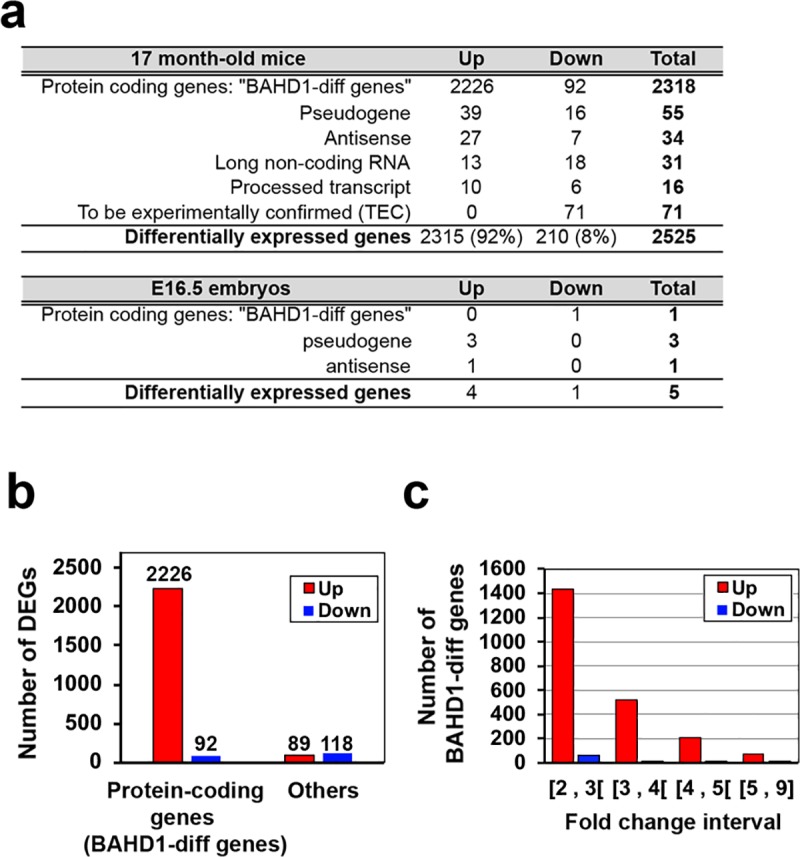
BAHD1 deficiency reshapes gene expression in the adult murine brain.(a) Summary of the transcriptomic analysis of Bahd1-/- and Bahd1+/+ brains from 17-month-old mice or embryos (E16.5). DEGs are categorized into gene types. (b) Number of upregulated (fold change ≥2) or downregulated (or ≤-2) genes. The number of protein-coding genes (termed “BAHD1-diff genes”) and that of other gene categories (“Others”) are indicated. (c) Number of BAHD1-diff genes per interval of fold change.